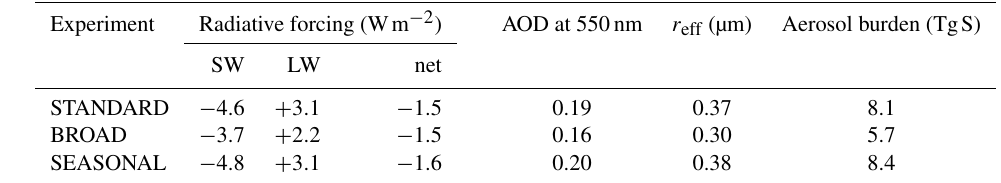
Table 2. Global mean quantities for experiments with 10TgSyr − 1 injection rate but different spatio-temporal injection patterns.